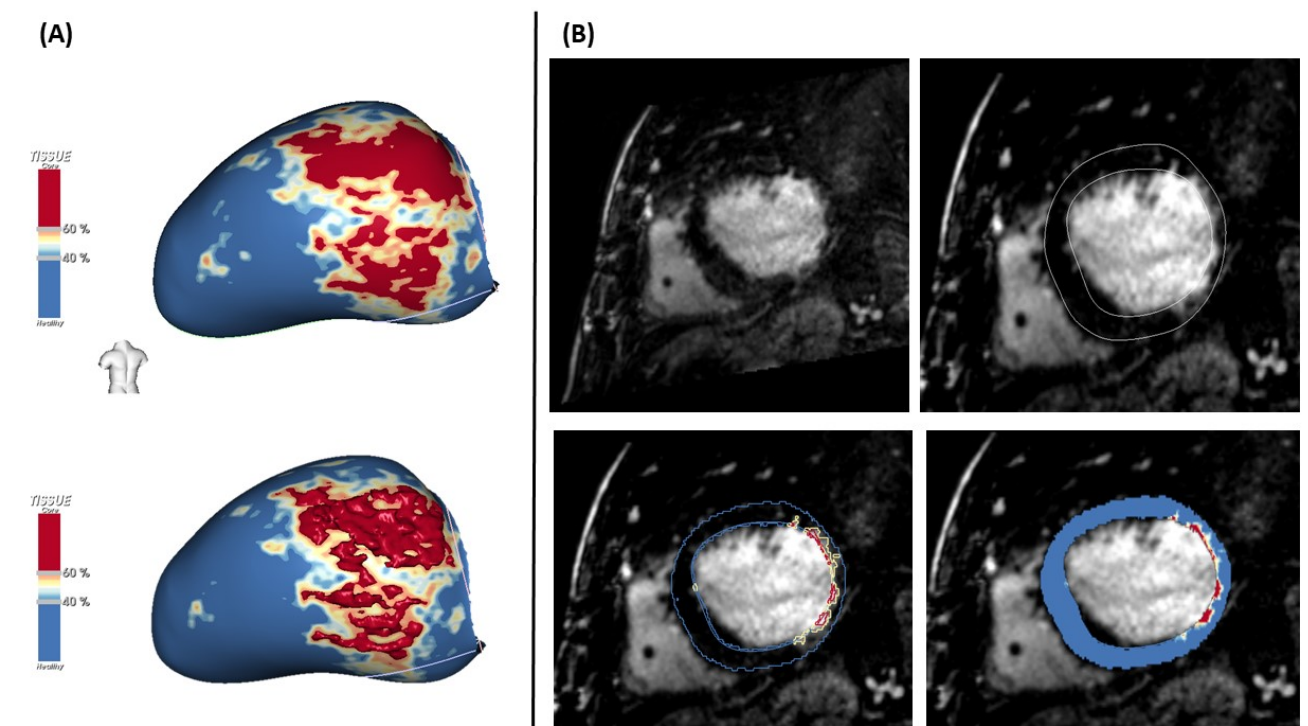
Figure 2. ( A ) Three-dimensional left ventricle reconstruction of LGE-MRI. LGE-based colour-coding is used to differentiate LV dense scar (red > 60% of maximum signal intensity) from border zone (yellow, 40–60% of maximum signal intensity) and healthy tissue (blue < 40%). ( B ) Raw images of LGE-MRI in a patient with chronic MI. Semiautomatic segmentation of epicardium and endocardium with detection of dense scar and border zone is shown.